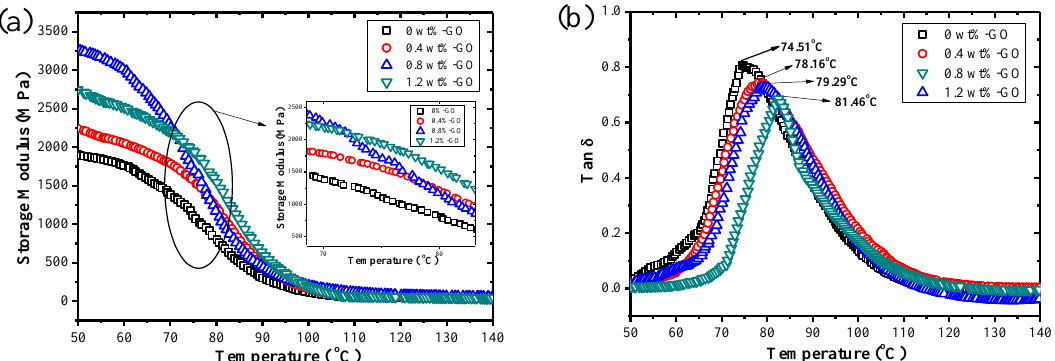
Figure 5. DMA curves of storage modulus ( a ) and tan delta ( b ) versus temperature for neat epoxy resin and GO-toughened epoxy resin composites .